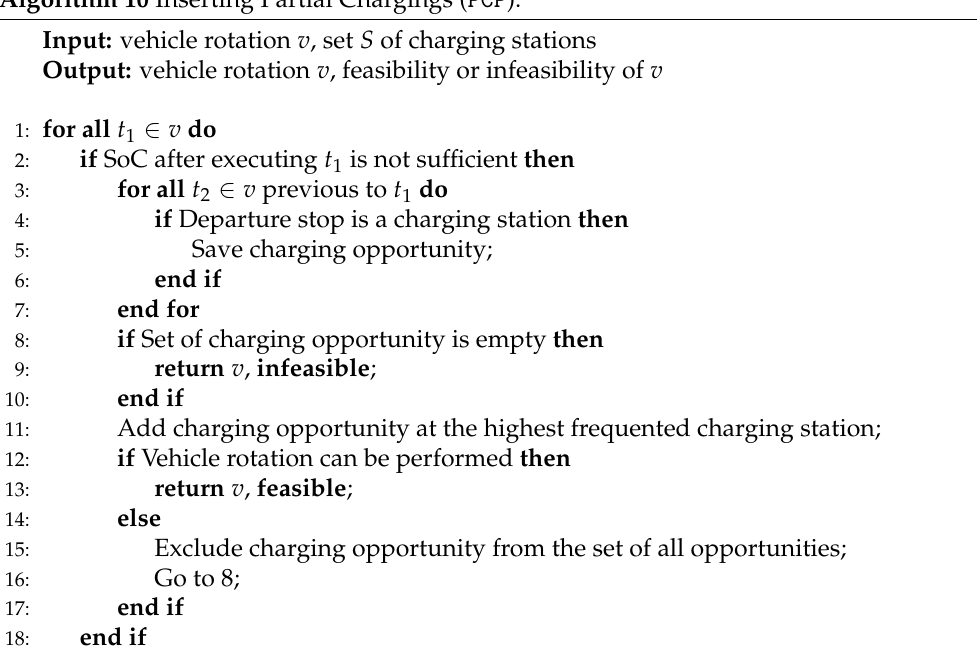
Algorithm 10 Inserting Partial Chargings ( PCP